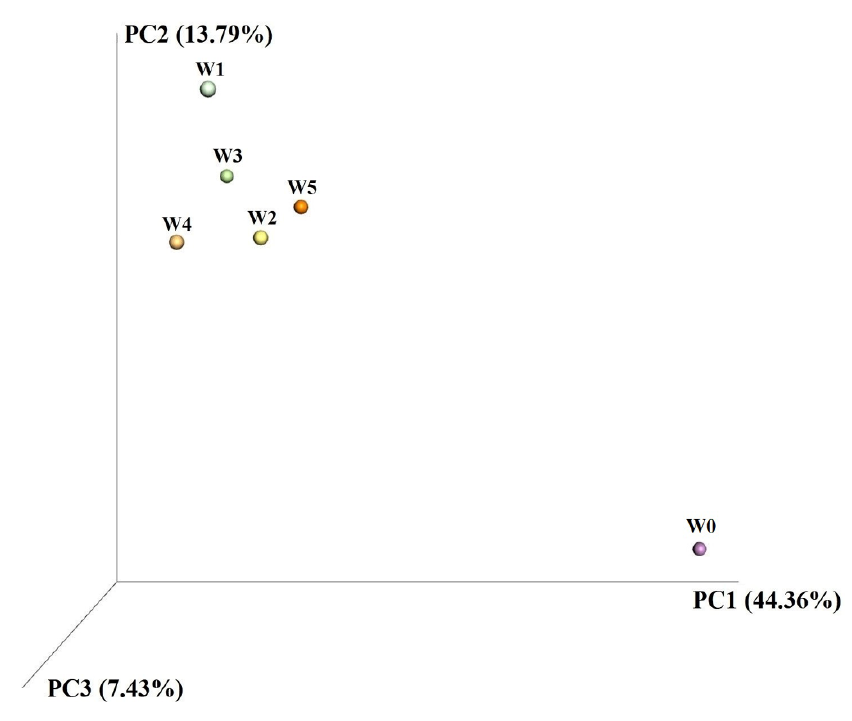
Figure 5. Principal Co-ordinates Analysis 3D map.